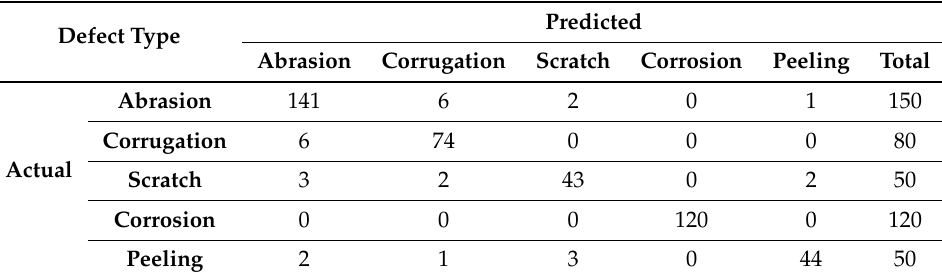
Table 4. Classification result by